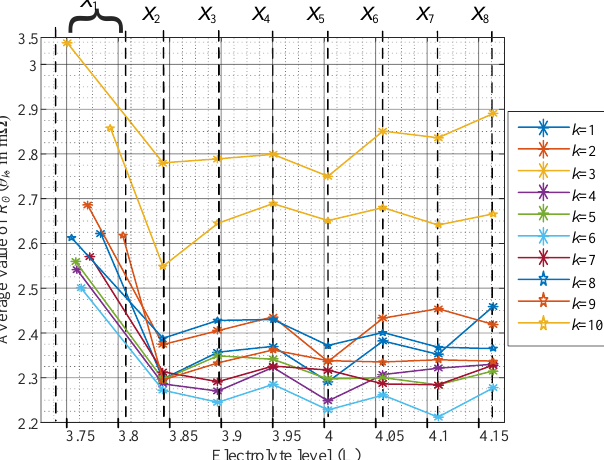
Figure 6. Evolution of the ohmic resistance with the eight electrolyte levels obtained for ten